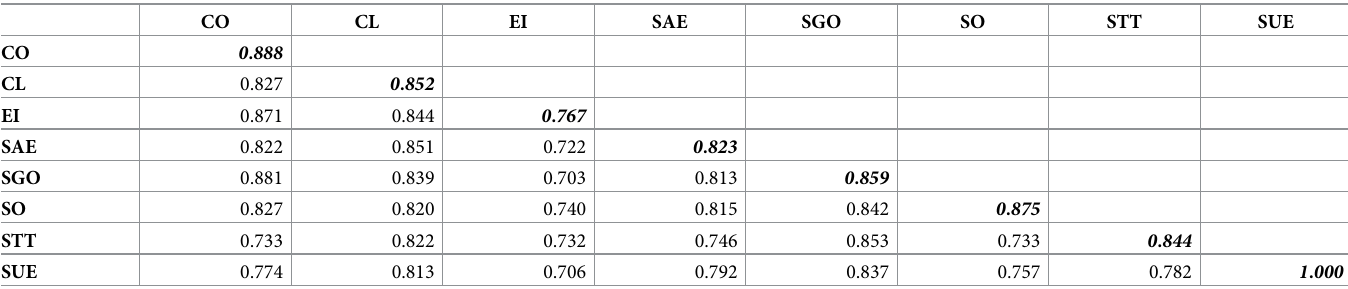
Table 5. Discriminant validity (Fornell and Larcker criterion).